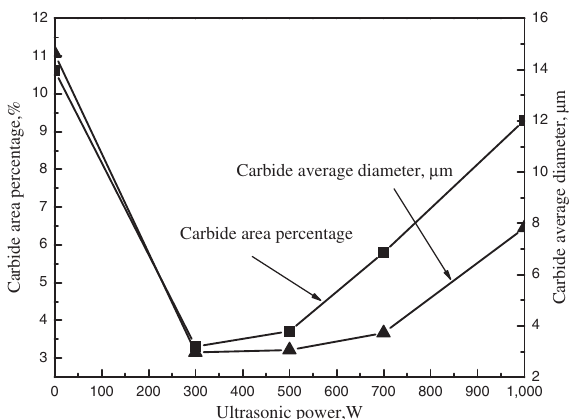
Figure 6: Relation between area percentage, average diameter of the carbide, and ultrasonic